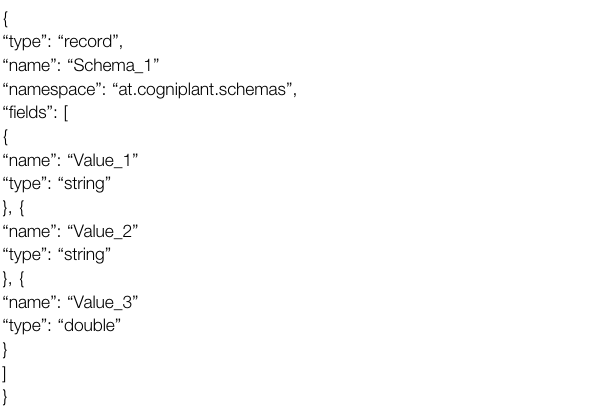
TABLE 5 | Con fi guration example of a schema in the Schema